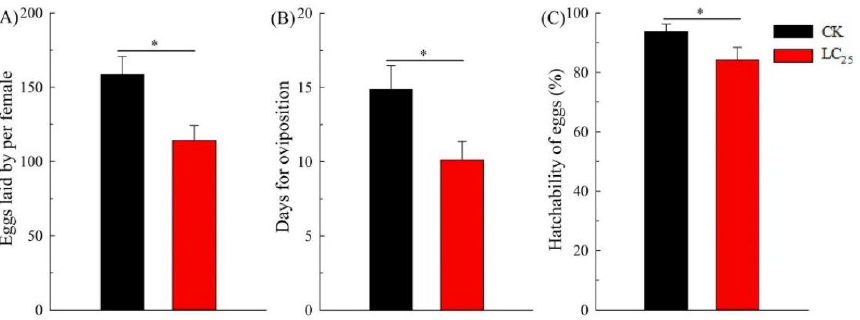
Figure 3. Fecundity ( A ), oviposition duration ( B ), and egg hatching rates ( C ) of the F 1 generations of B. tabaci in CK and LC 25 treatment groups. Values are presented as means ± SE. Asterisks above error bars indicate significant differences ( p < 0.05).